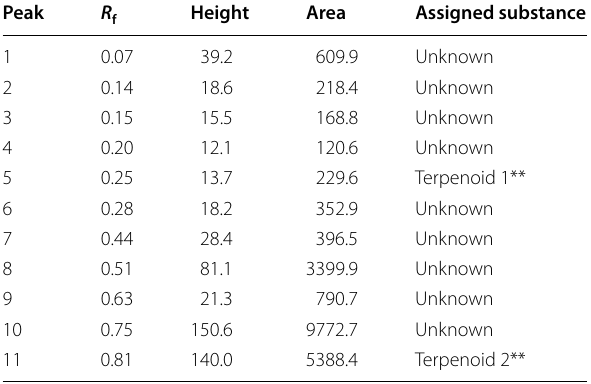
** When compared in similar conditions[21] Table 9 Peak table of BPSAL in mobile phase-II Peak